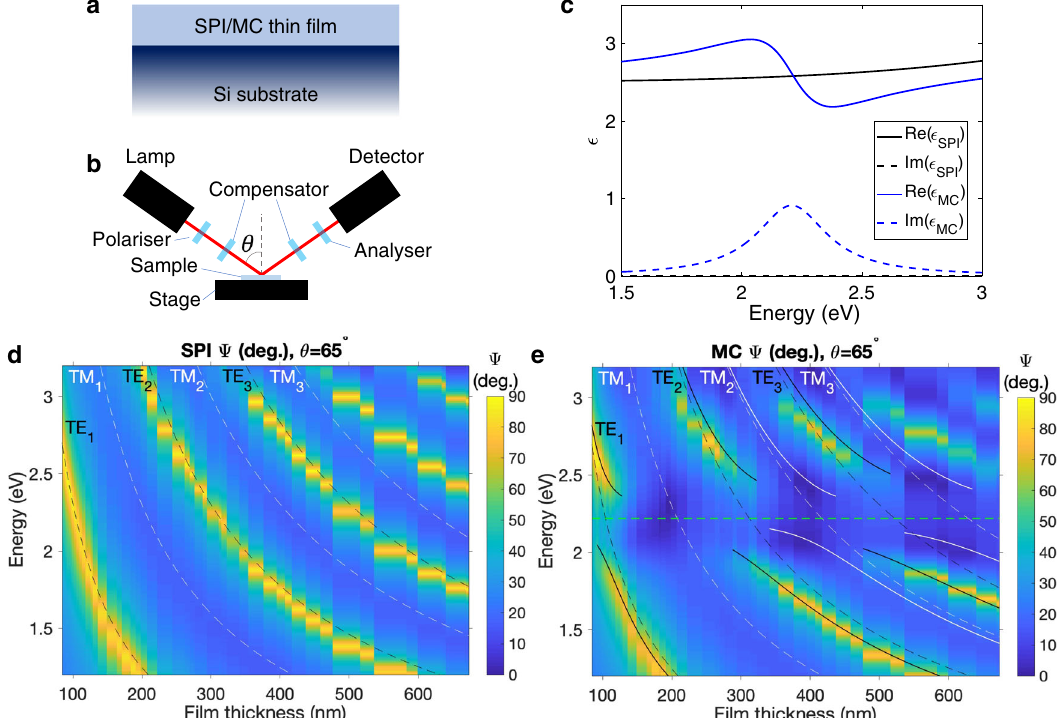
Fig. 1 Cavity-free strong light-matter coupling. a Sample design: SPI/MC fi lm on silicon substrate. b Ellipsometer schematic. c Complex permittivities ϵ of SPI and MC, as derived from ellipsometry for a fi lm of thickness 109 nm. d , e Dispersion plots constructed using the ellipsometric parameter Ψ for d SPI and e MC fi lms over a range of thicknesses at fi xed angle θ = 65 ° . The dashed lines in d , e indicate the positions of the uncoupled TE (black) and TM (white) leaky modes. The green dashed line in e at E = 2.22 eV indicates the position of the MC molecular resonance. The solid lines show the predicted positions of polariton branches using the 2 N coupled oscillator model. The coupled TE polariton branches (black) were fi t with a coupling strength g = 225 meV. The TM 2 and TM 3 polariton branches (white) were fi t with g = 185 meV and g = 200 meV, respectively. We did not perform a coupled oscillator fi t for the TM 1 mode since it does not show any clear